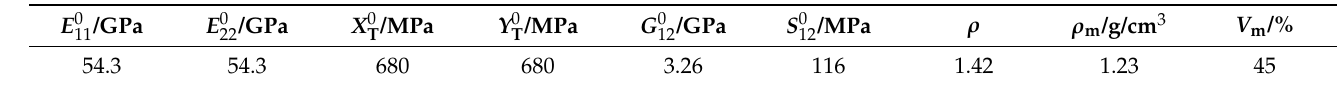
Table 2. Material parameters